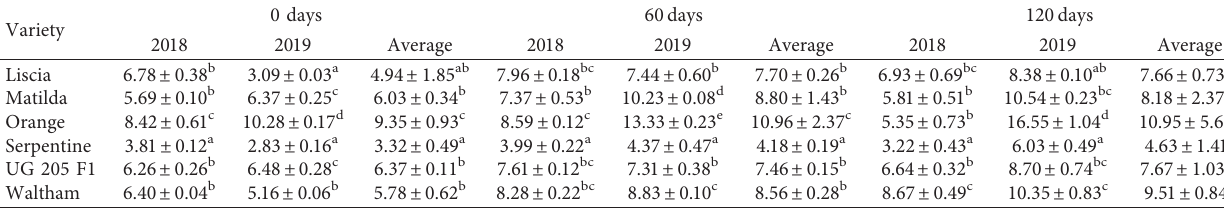
Table 2: Total carotenoids content during storage in fresh matter (FM) [mg/100g].